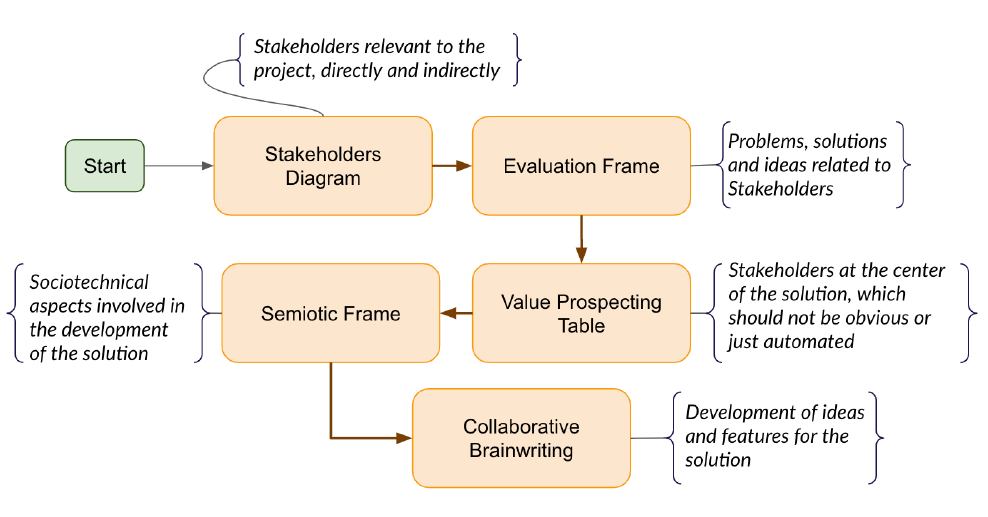
Figure 1. Activities developed in the Socially Aware Design